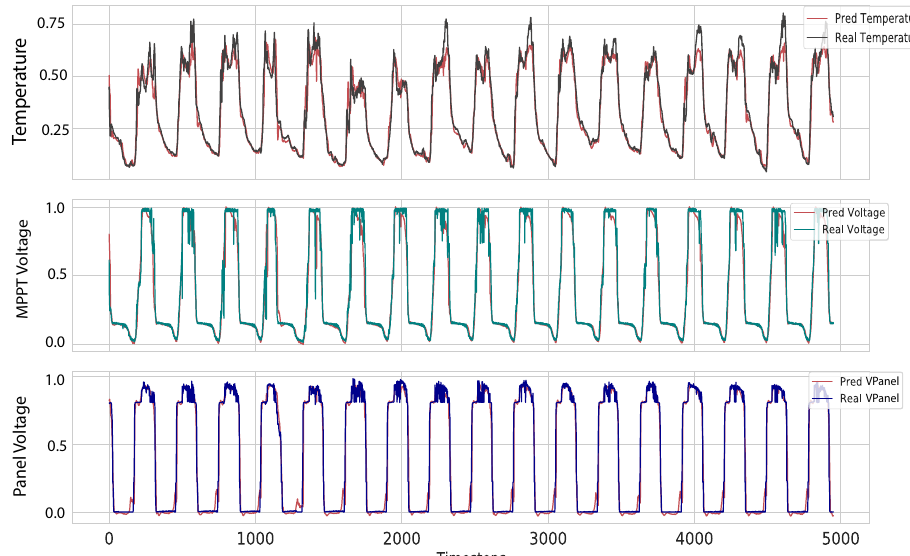
Figure 16. Predictions over testing data using the model with Attention.